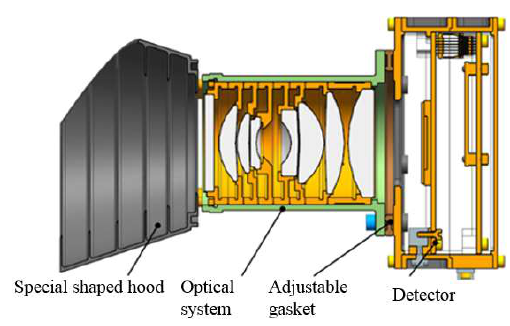
Figure 8. Mechanical structure of the camera.